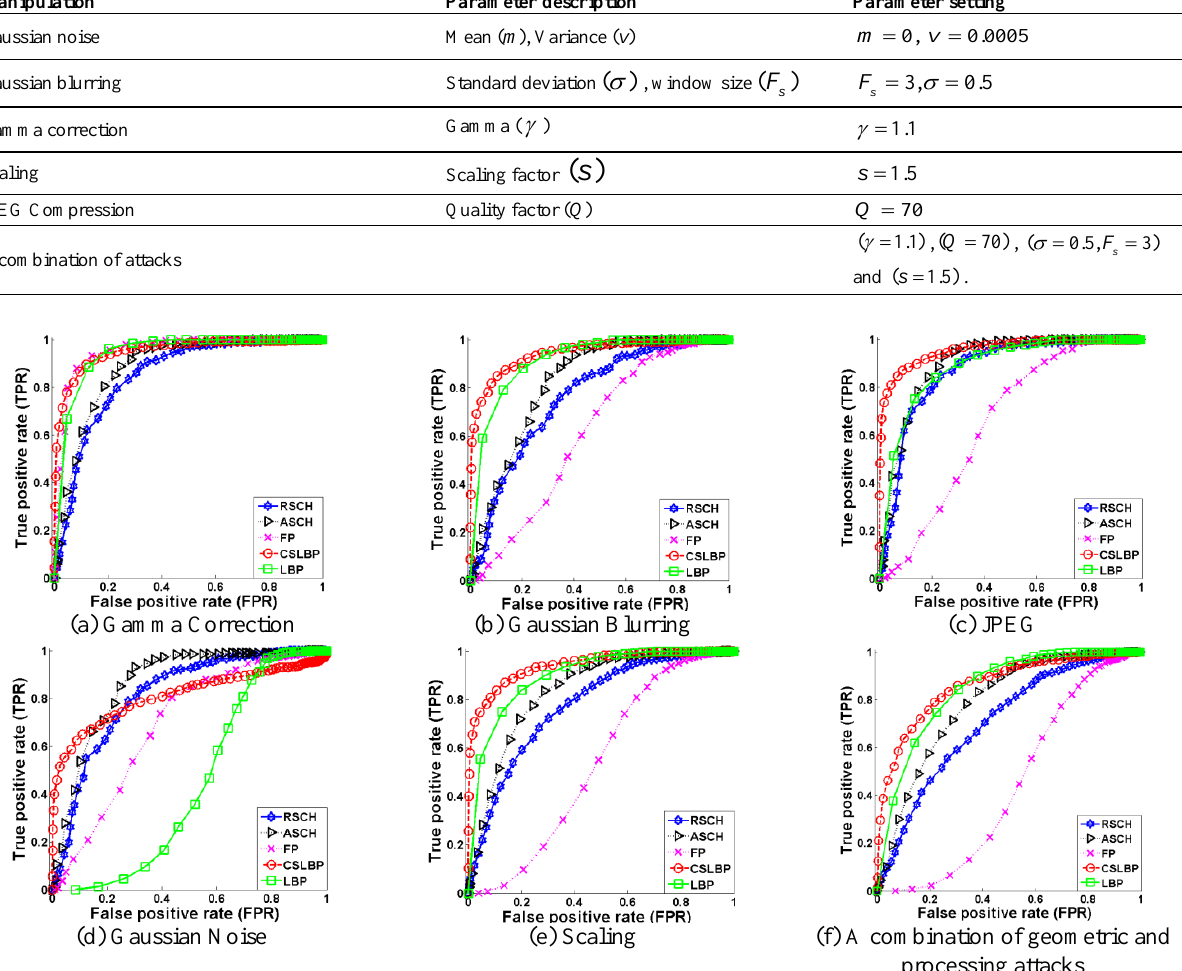
Figure 6. ROC curve comparisons between our hashing and other methods in image authentication test.